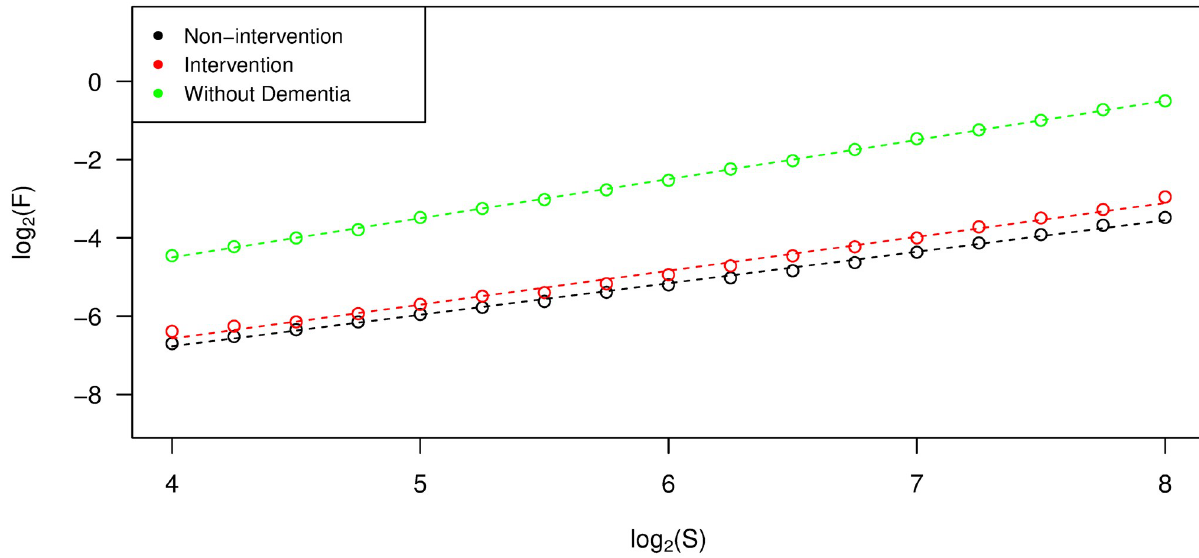
Fig 5. Estimation of DFA scaling exponents. Data points and their linear regression lines for the estimation of DFA scaling exponents (slopes) from three participants, one from each of the non-intervention group, the intervention group, and the group of individuals without dementia.